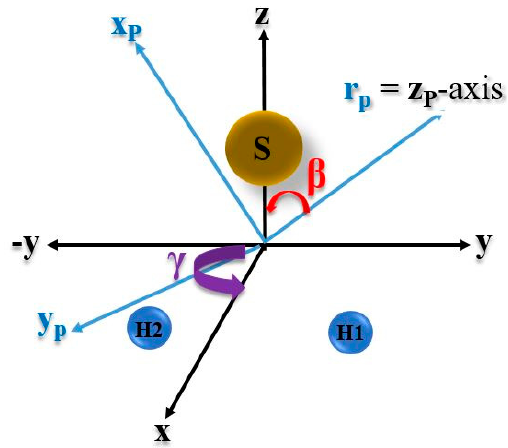
Figure 2. Diagram showing Euler angles ( α , β , γ ) in H 2 S molecule where, (x, y, z) is the set of orthogonal vector for the fixed molecular frame. r P is the product vector, as defined in Equation (14), while x p is an arbitrary vector perpendicular to r P and y p is perpendicular to both r P and x p . ( α , β , γ ) are the standard Euler angles through which (x p , y p , r P ) are transformed to (x, y, z).